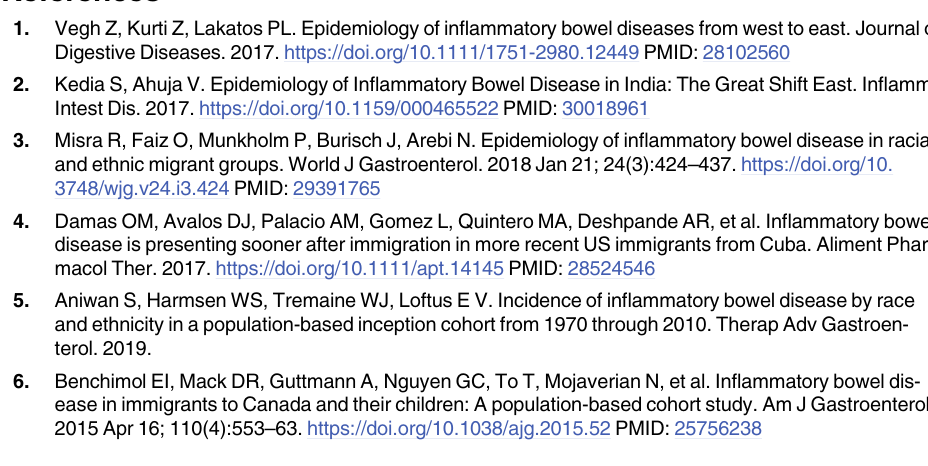
S1 Table. Baseline characteristics of South Asian American